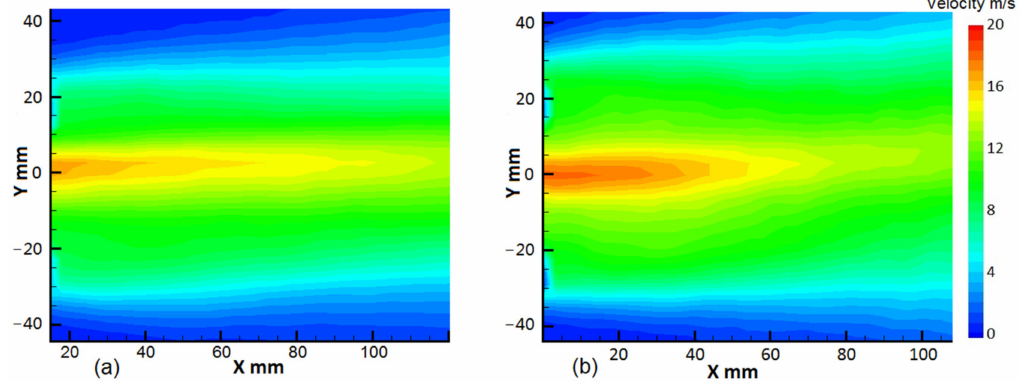
Figure 8. Time average velocity distribution of nozzle A in case 3 ( a ) and case 4 ( b